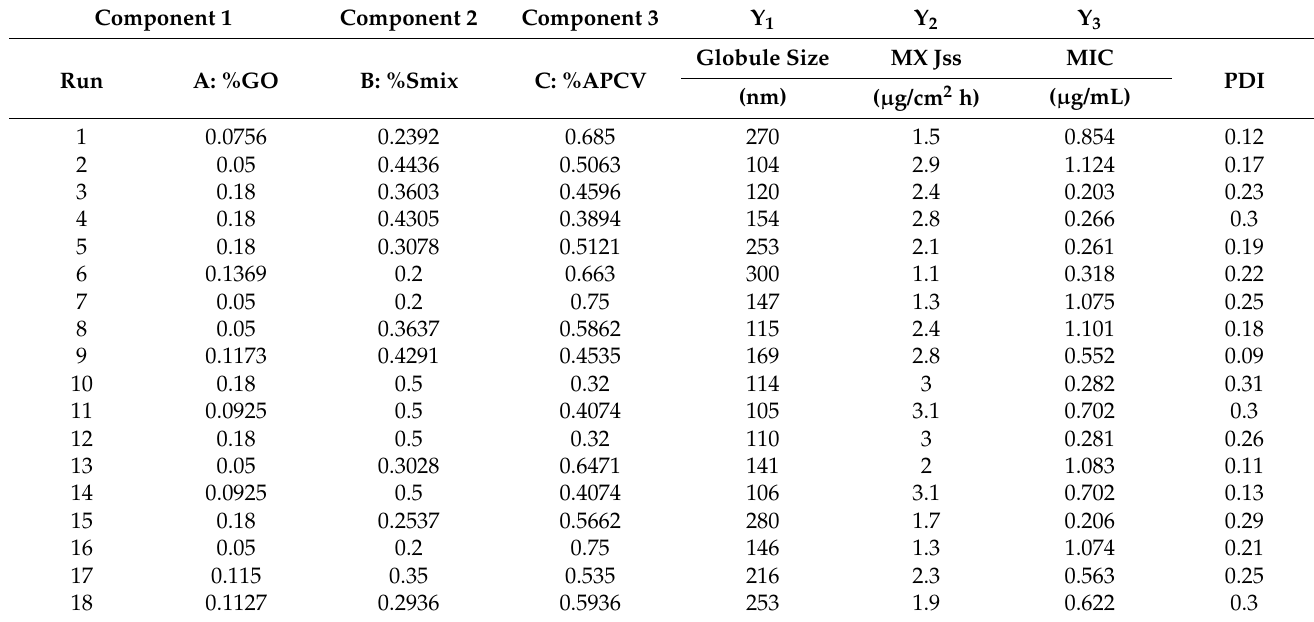
Table 3. Distance coordinate exchange quadratic mixture design responses of MX-GO-APCV